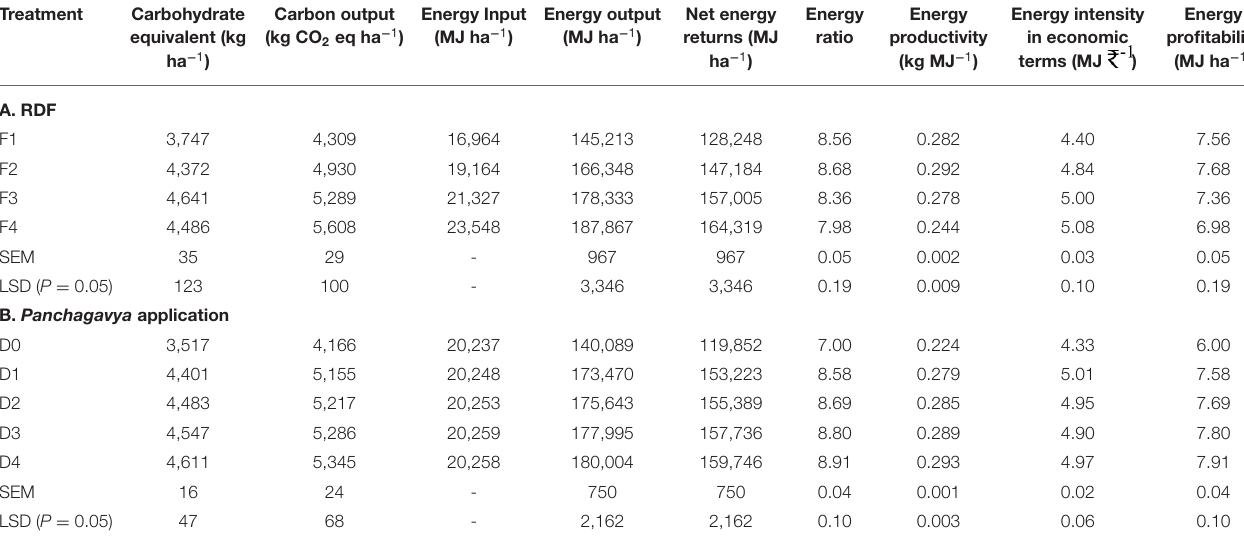
TABLE 11 | Carbohydrate equivalent, carbon output and energy use efficiency of rice as influenced by fertility levels and panchagavya (pooled data of 2 years). Treatment Carbohydrate equivalent